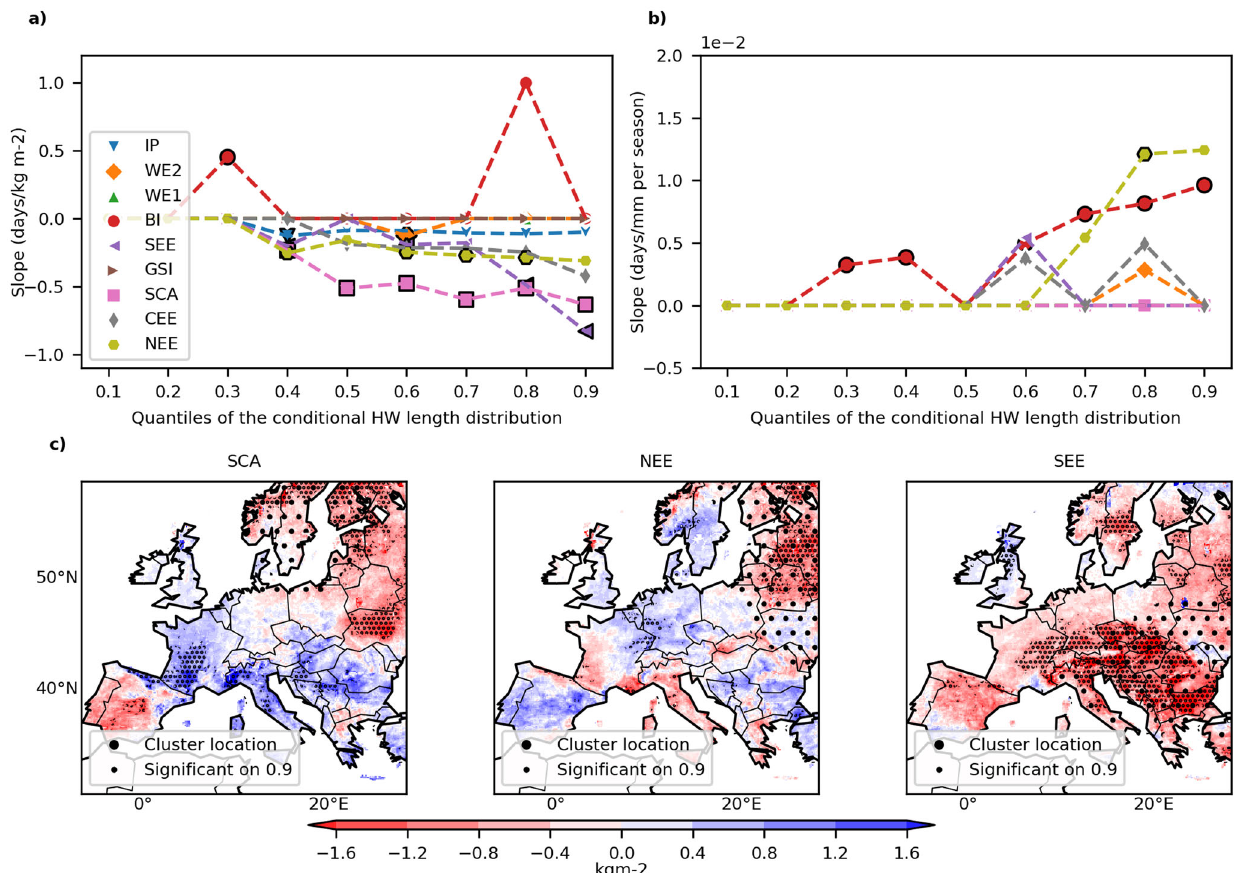
Fig. 6 Quantile regression slopes for N HW in relation to moisture-related variables in fall after. N HW versus mrsos OND ( a ) and pr OND ( b ). Statistically signi fi cant slopes with a 90% con fi dence level with a two-sided t -test are identi fi ed with black edging. mrsos OND for the 25 years with the highest number of heatwave days in chosen patterns with signi fi cant precipitation anomalies ( c